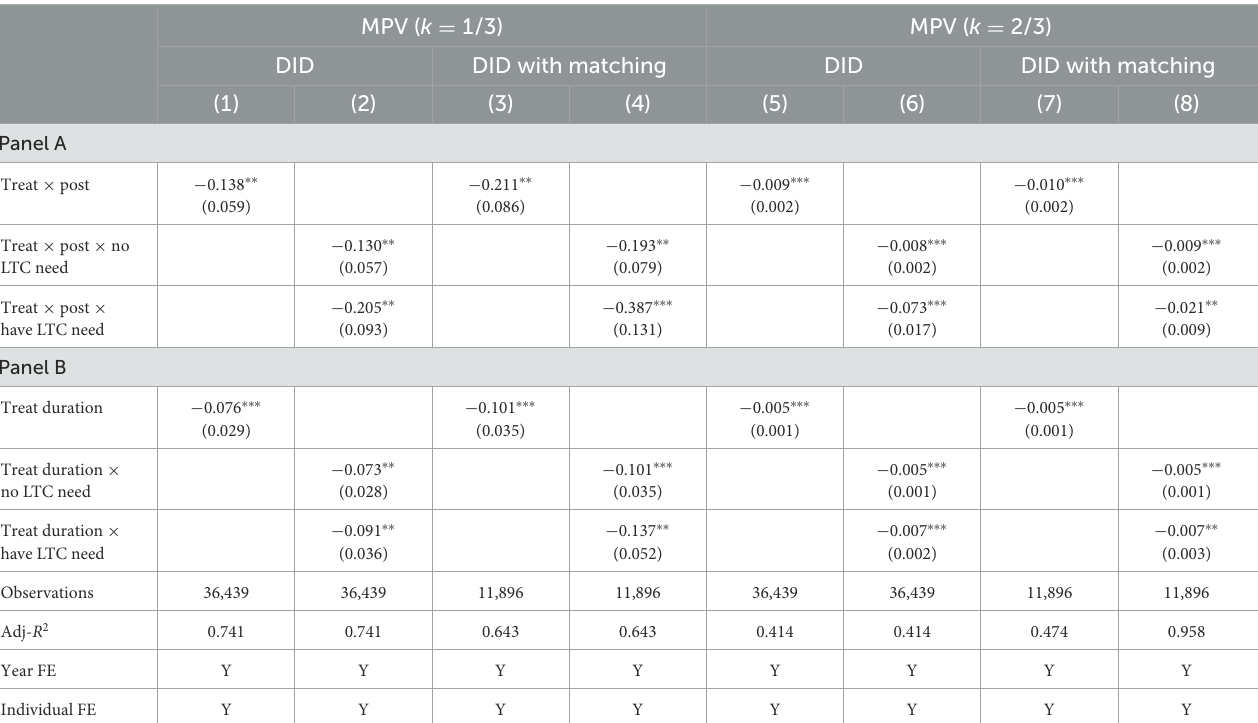
TABLE 6 Effect of LTCI on MPV.